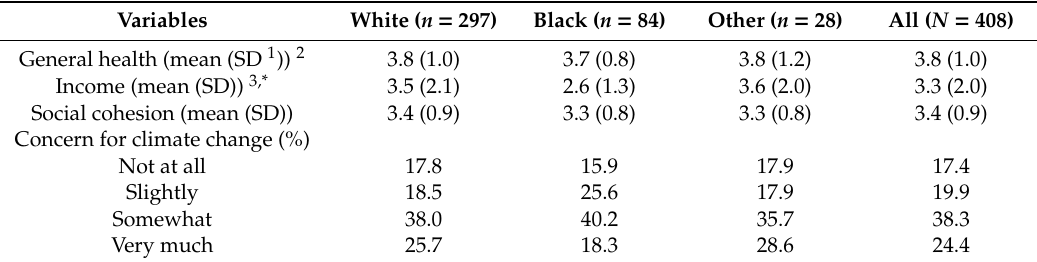
Table 3. Exogenous variables by racial group, weighted ( N =